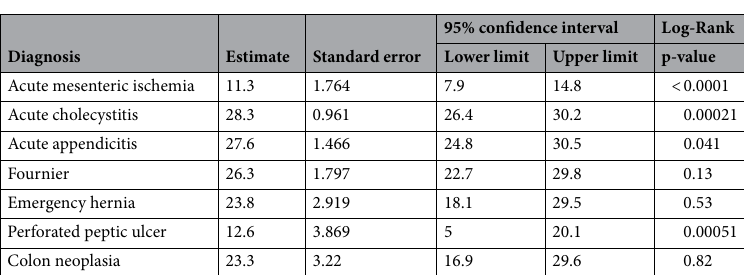
Table 3. Estimate in days of fatal events during the postoperative period and Log-Rank comparison with overall mortality.